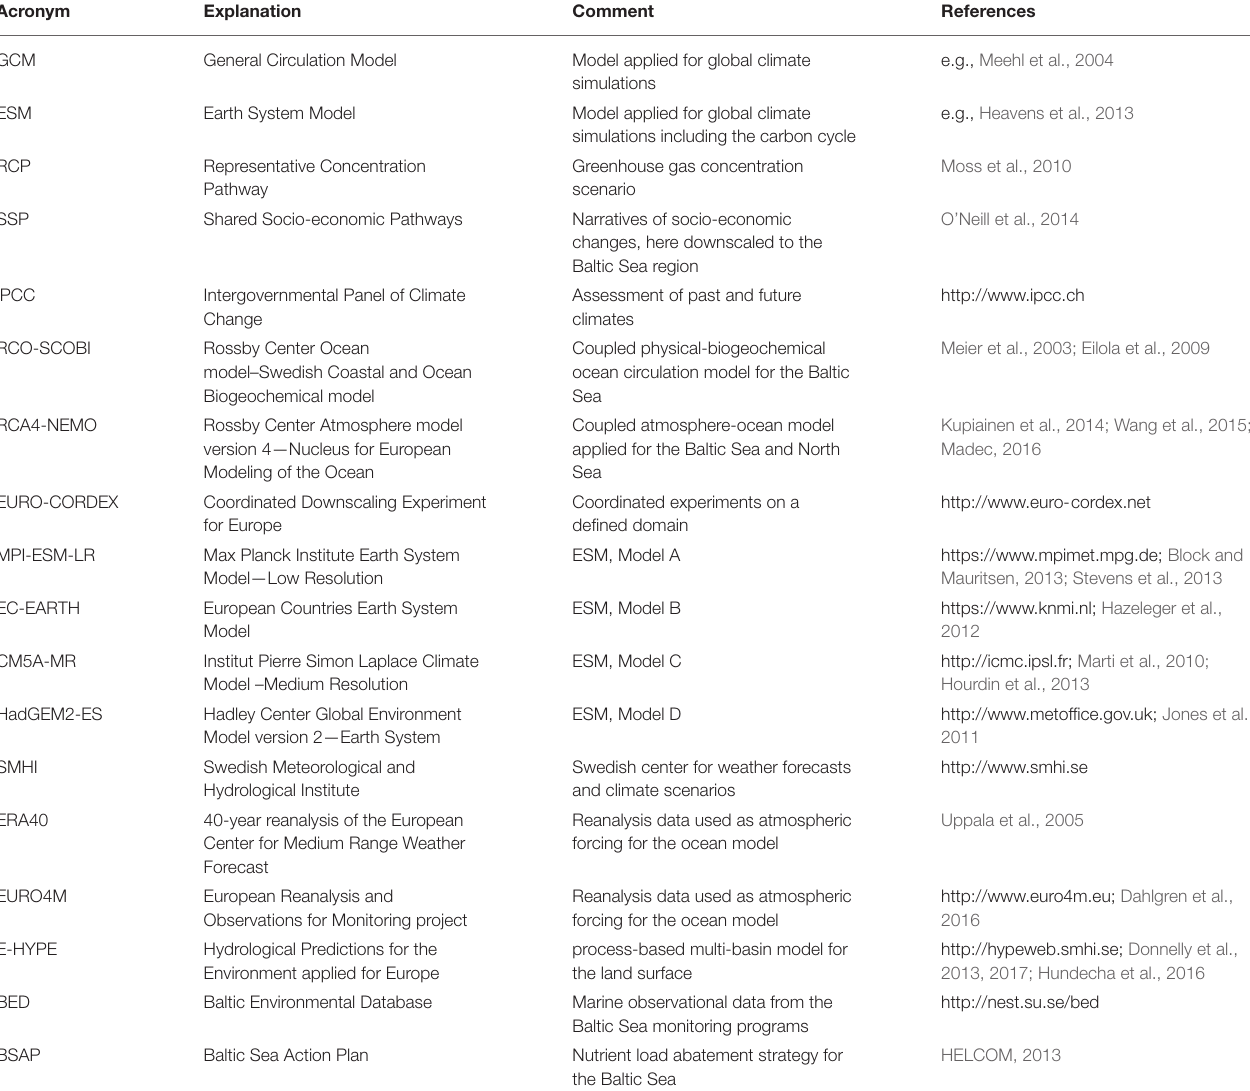
TABLE 1 | List of